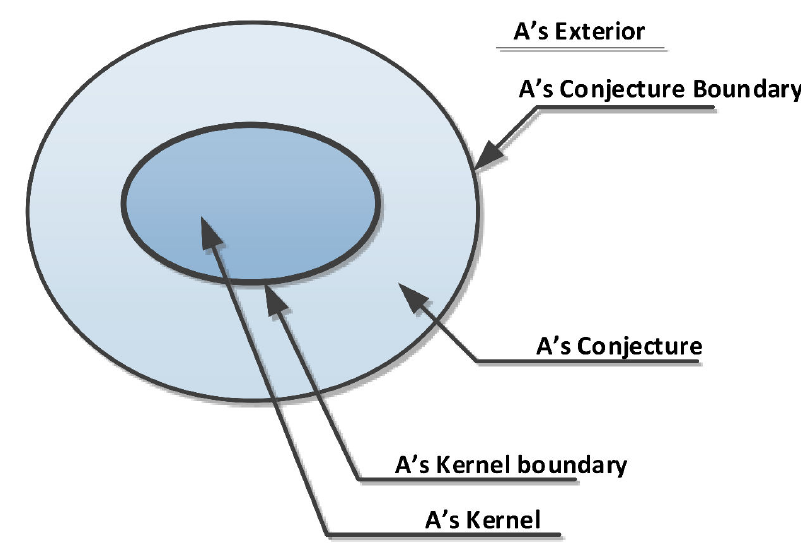
Figure 3. Topological parts of a simple fuzzy-crisp